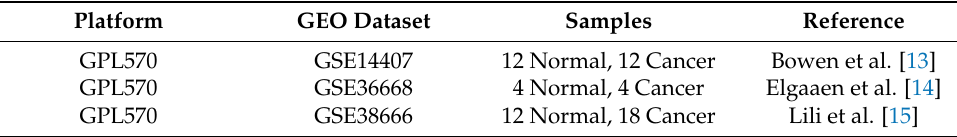
Table 1. Basic information of microarray data from NCBI GEO